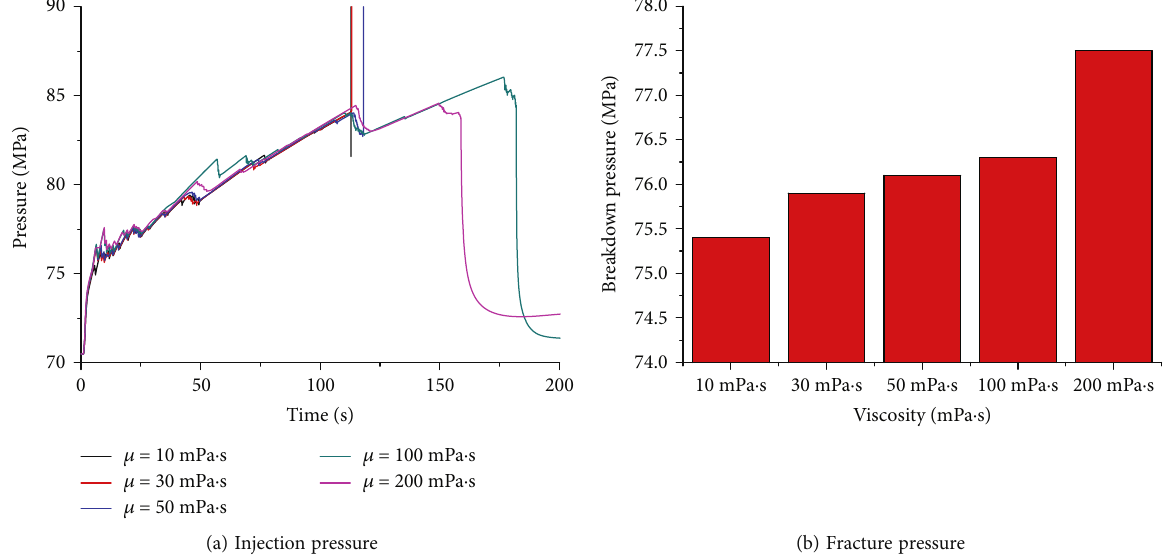
Figure 20: Injection pressure and fracture pressure at the NF approaching angle of 30 ° and fl uid viscosity of 10-200 mPa ·